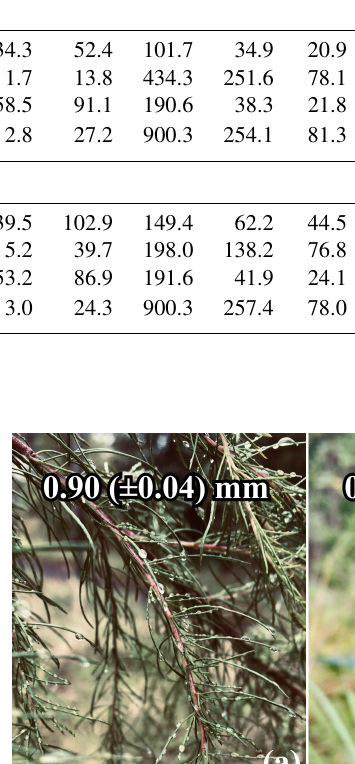
Table 2. Descriptive statistics of relative throughfall ( P T ) and stemflow ( P S ) yield from dogfennel plants expressed as a proportion of gross rainfall ( P g ) and modeled overstory throughfall ( P (cid:48) ). Coefficients of variation (CV) and quartile variation (CQV) are also provided. For T , o storms where dew occurred in the understory, dew was not measured by above-canopy P g gauges but was included in the P (cid:48) assuming that dew represented at least an additional 1.33mm (i.e., S u ).